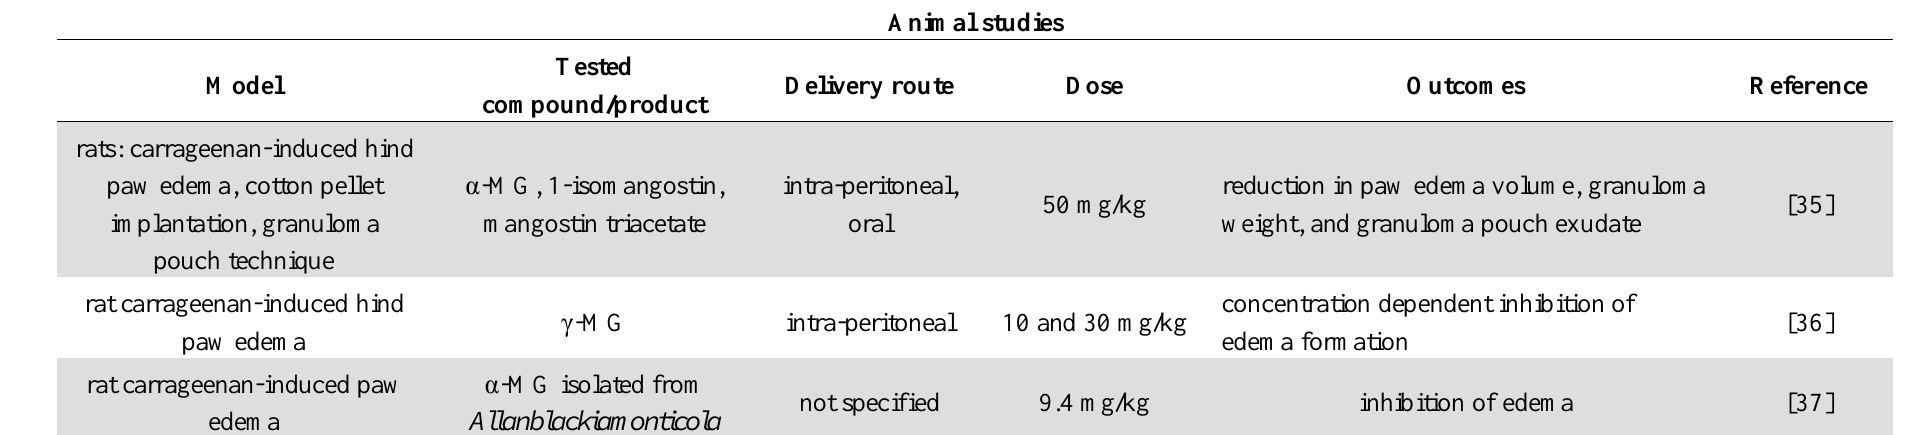
Table 5. In vivo anti-inflammatory activities of mangosteen